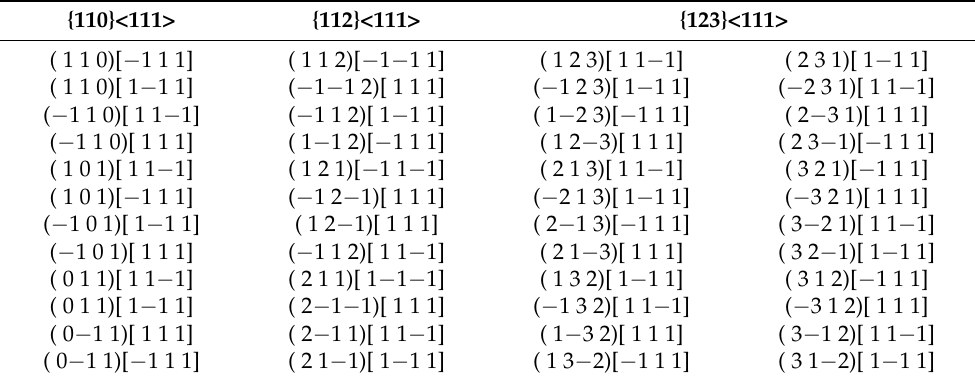
Table 3. Slip systems for the S45C